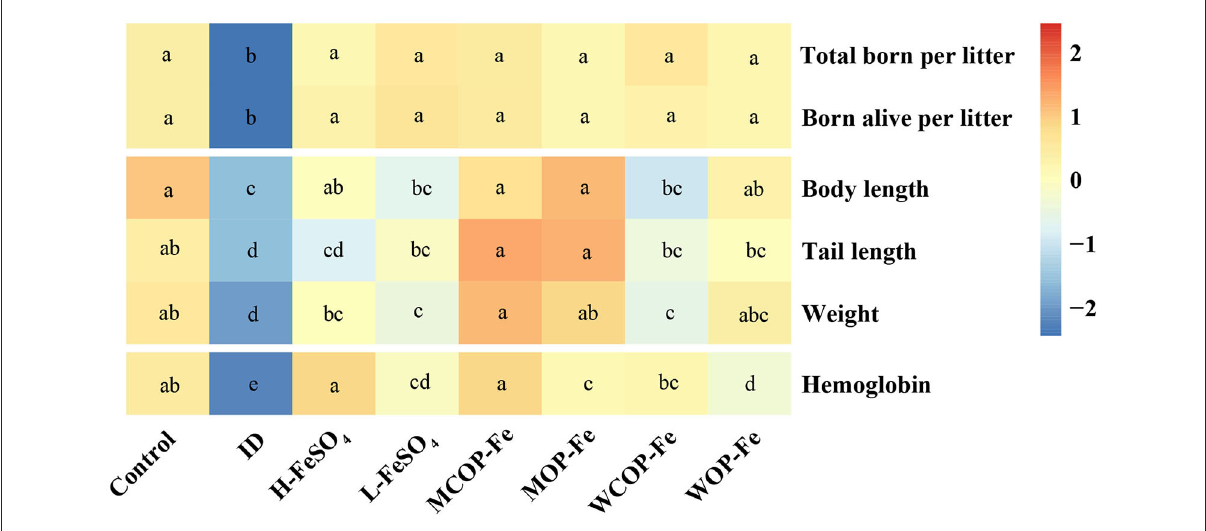
FIGURE6 The pregnancy outcome and development of offspring at birth. The heatmap shows the pregnancy outcome and development of offspring at birth after normalization. Values marked with different letters show significant differences. ID, iron deficiency anemia model group (4 ppm FeSO 4 ); H-FeSO 4 , 400 ppm FeSO 4 ; L-FeSO 4 , 40 ppm FeSO 4 ; MCOP-Fe, 400 ppm marine fish oligopeptide iron complex; MOP-Fe, 40 ppm marine fish oligopeptide iron complex; WCOP-Fe, 400 ppm whey protein oligopeptide iron complex; WOP-Fe, 40 ppm whey protein oligopeptide iron